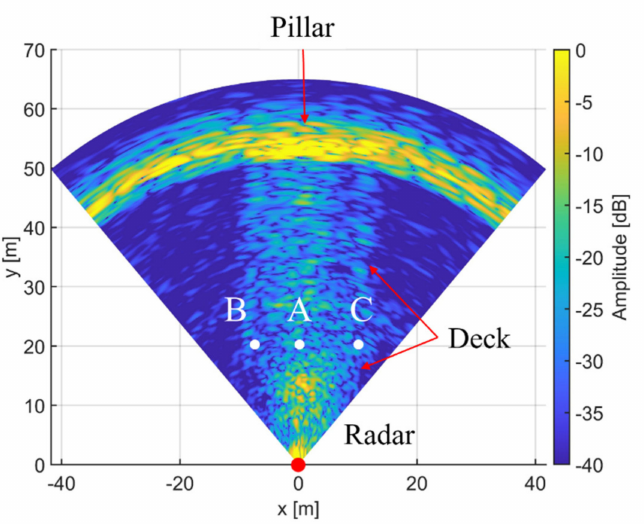
Figure 15. Radar image of Vespucci bridge focused on the horizontal plane at z = 6.5 m. The targets A, B, C were used for the displacement